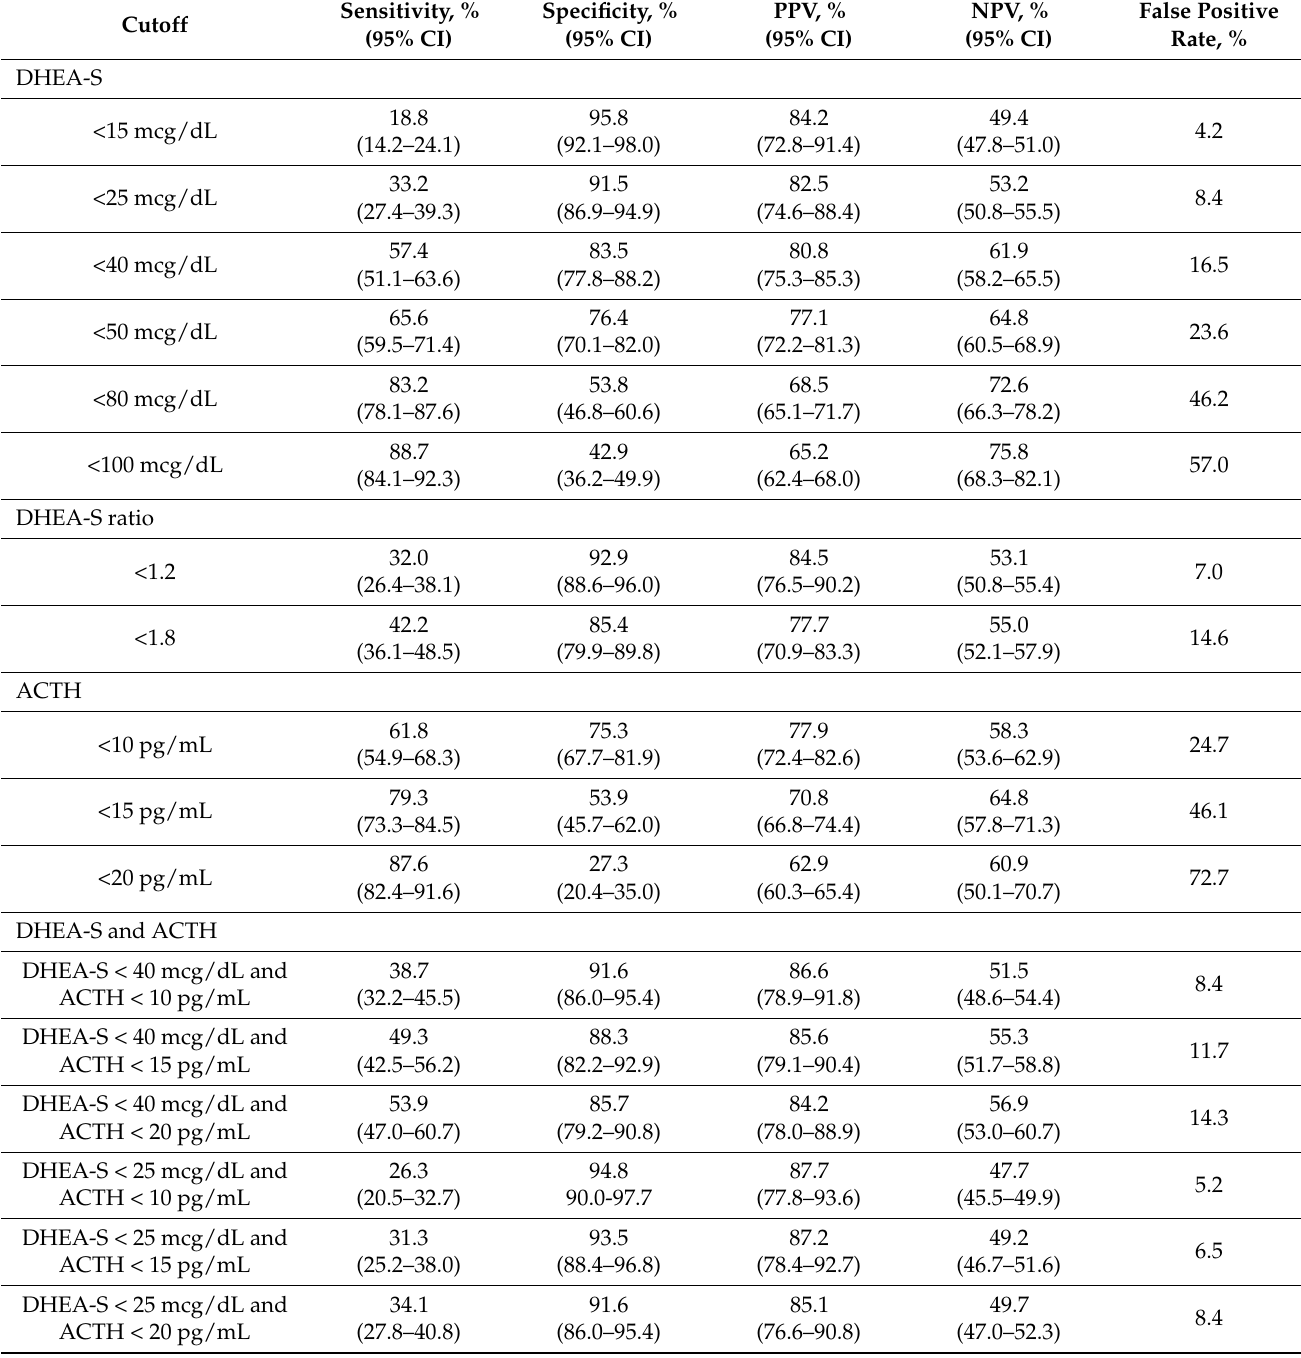
Table 2. Diagnostic accuracy parameters for serum DHEA-S and ACTH concentration cutoffs in diagnosing autonomous cortisol